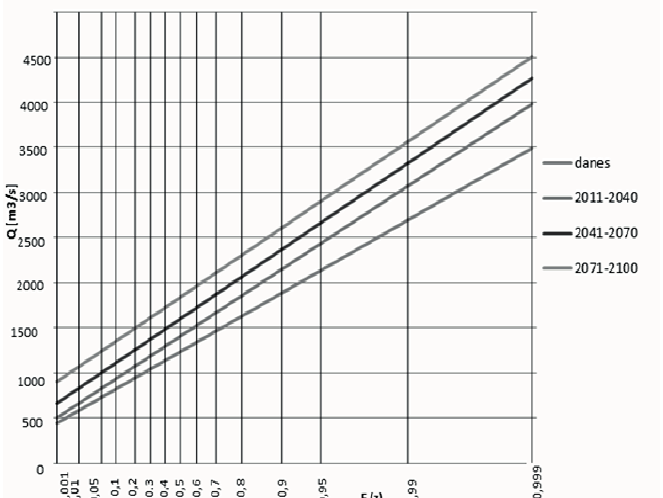
Fig. 6 Dependence between the discharge and the distribution function for the water gauging station